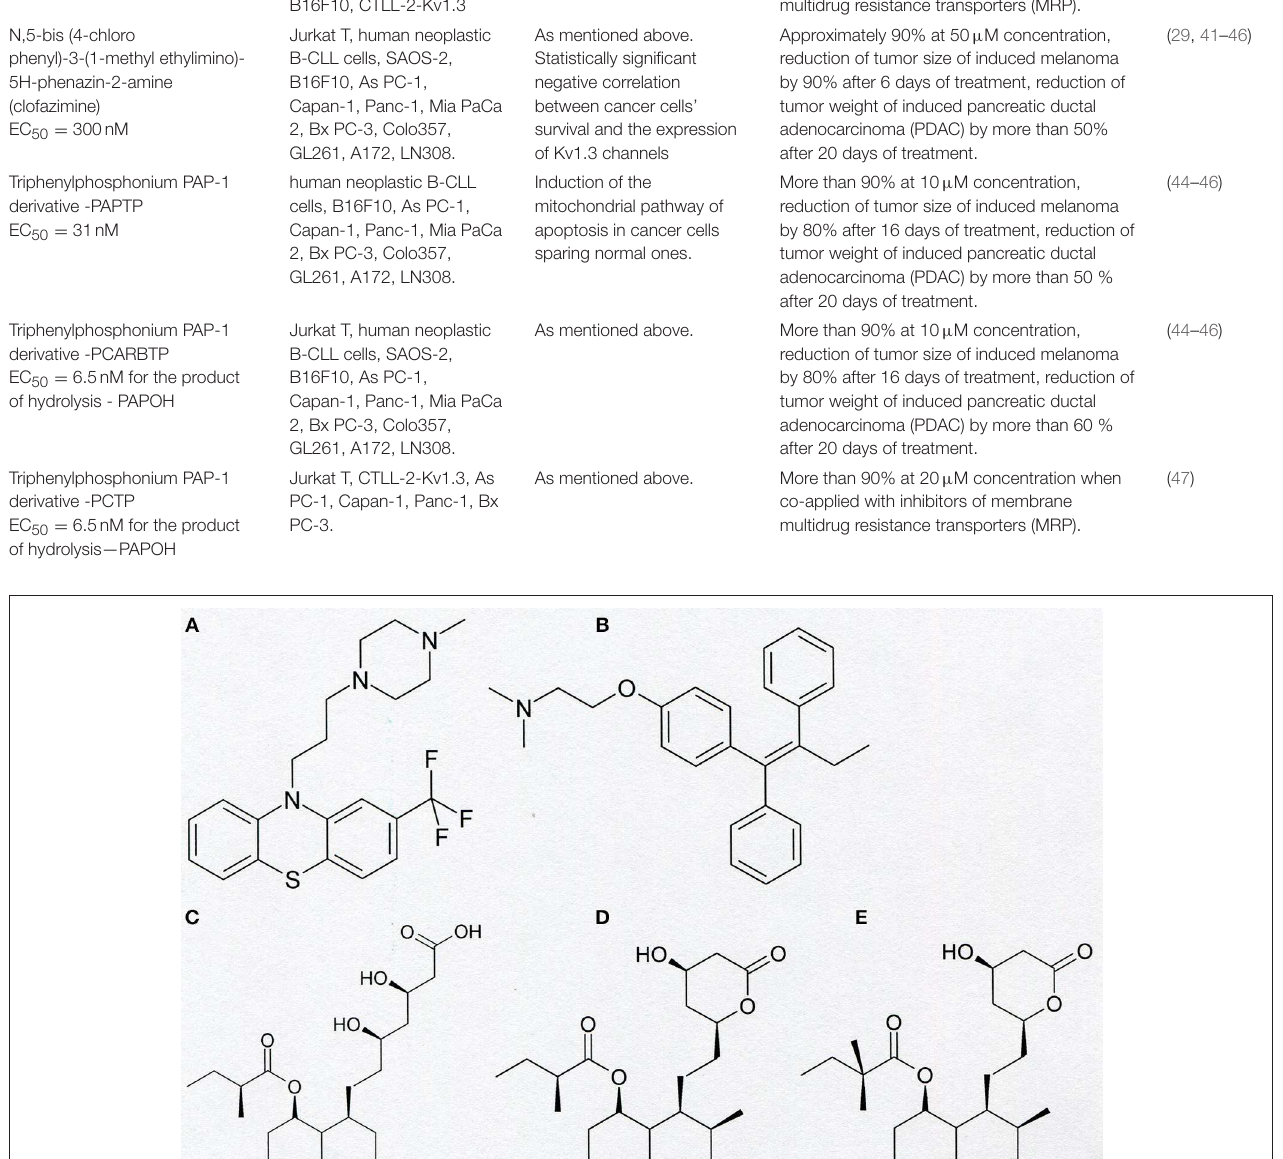
Frontiers in Oncology |